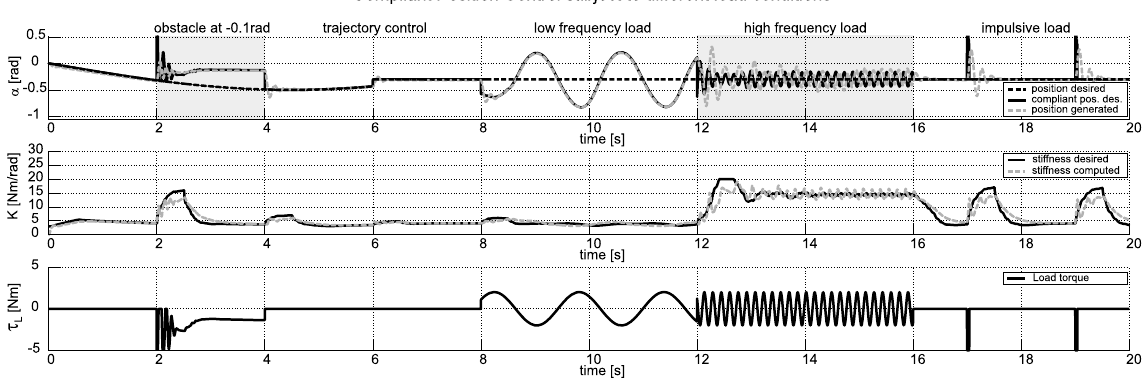
Fig. 8. Simulation results of the position control scheme and compliance adaptation in presence of different perturbing torques. Depending on the perturbation, joint stiffness adapts producing a stabilizing effect at joint